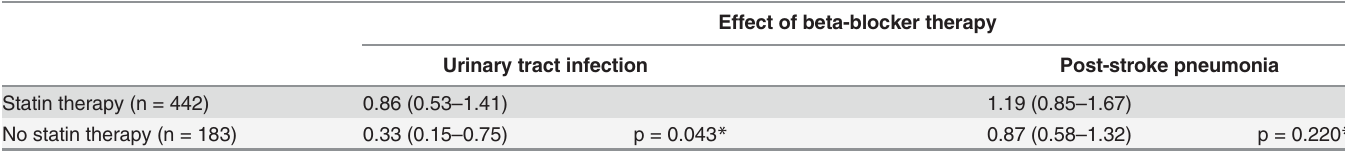
Table 3. Effect of beta-blocker therapy on post-stroke infections strati fi ed by statin therapy.